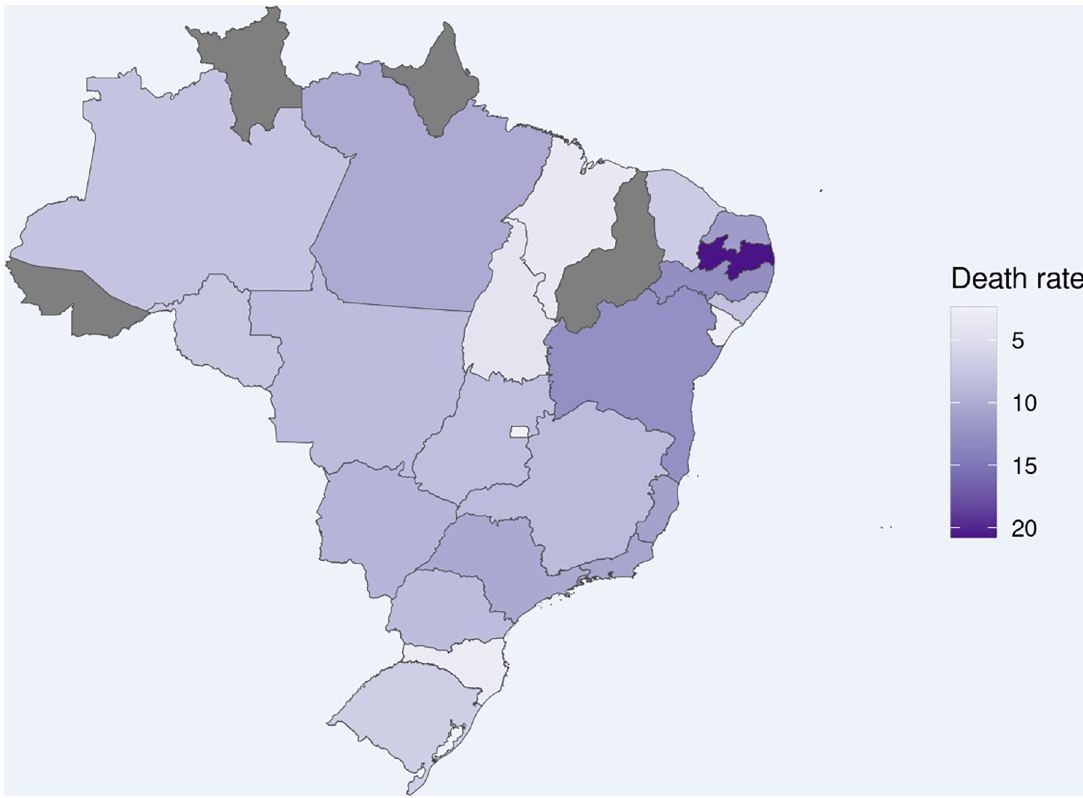
Fig 4. Maternal death ratio by unspecified cause in Brazilian states (elaborated by the authors). Maternal death ratio was calculated using the number of maternal deaths/100,000 live births, which was estimated from the number of live births from 2019 from SINASC database. Each state is colored according to tones of purple according to the shown scale. The number of live births in each state in 2019 was considered for this estimate (http://svs.aids.gov.br/dantps/centrais-de-conteudos/paineis-de-monitoramento/natalidade/nascidos-